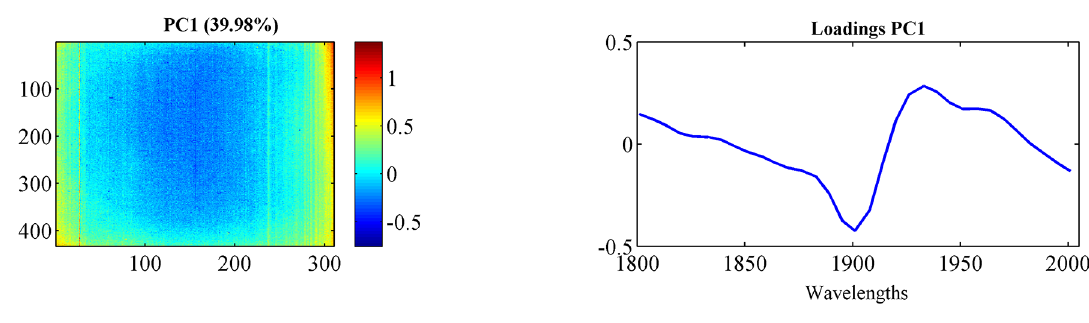
Figure 7. Scores images and loadings of PCA performed on the entire (75 x 55 mm) sample after exposure to NaOH during 96 h. The darker blue pixels show the area exposed.